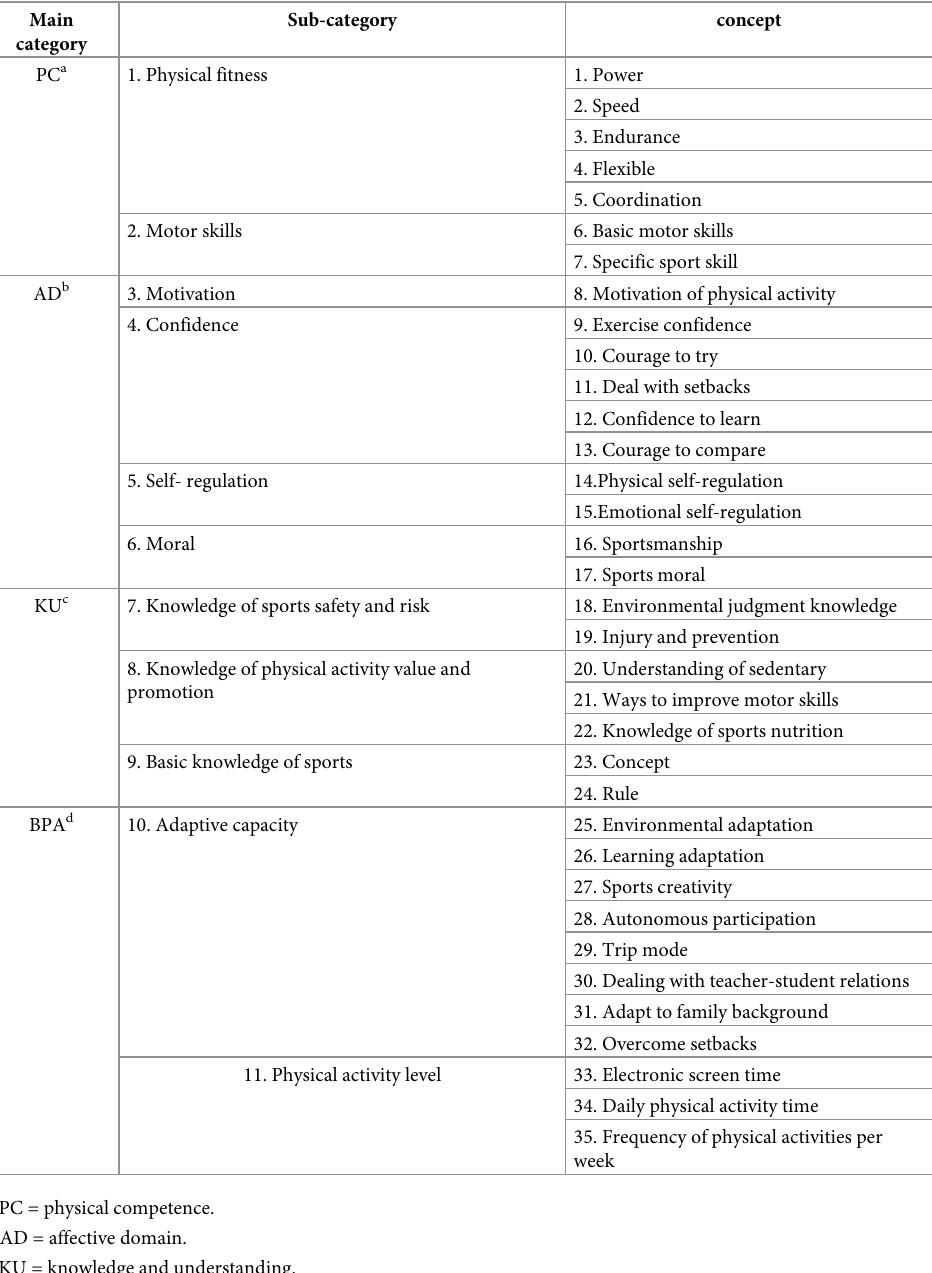
Table 4. Axial coding